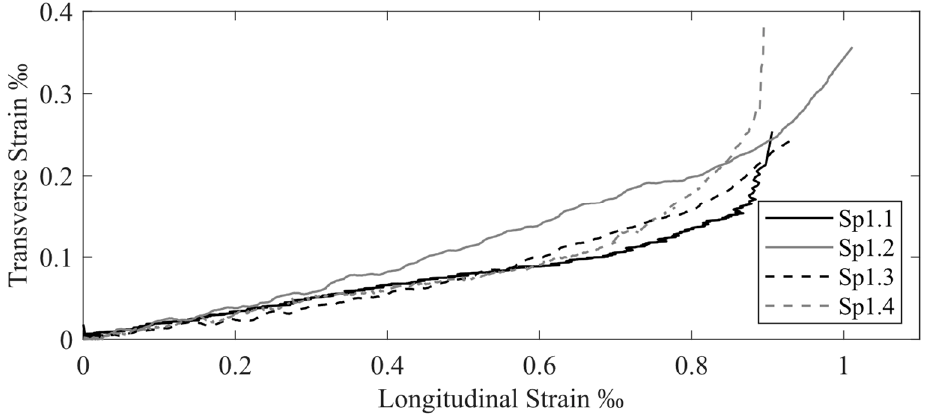
Figure 8. Dependences of transverse strains on longitudinal ones.